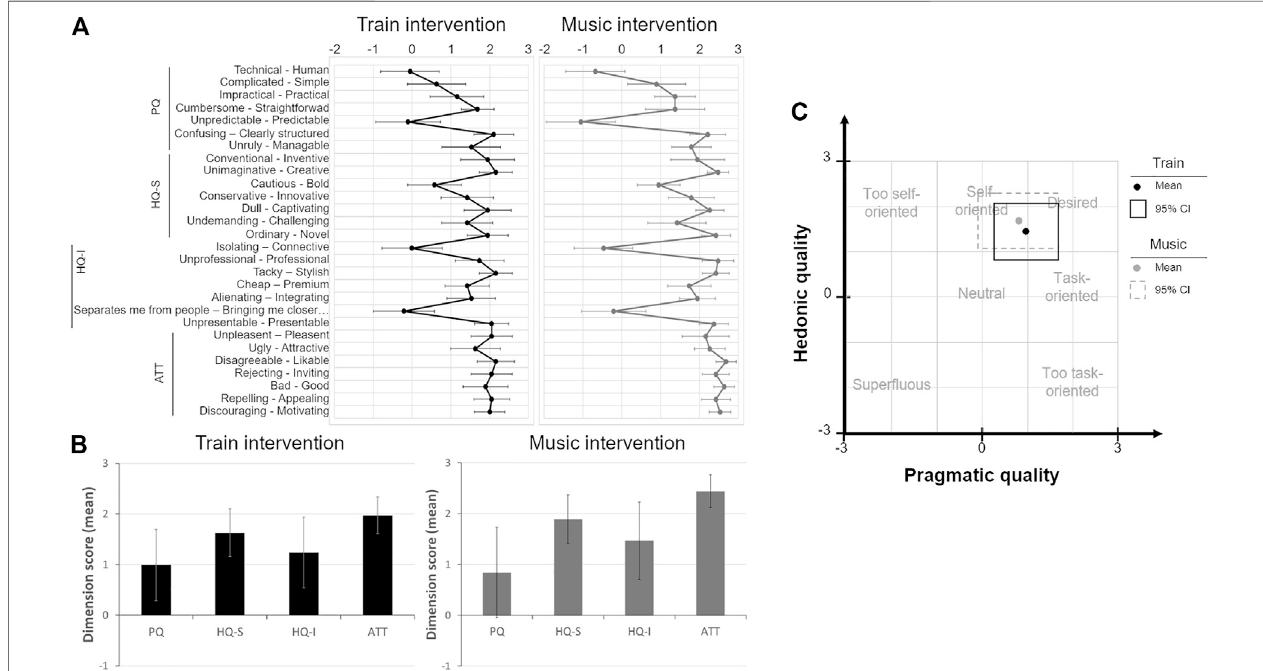
FIGURE 2 | User experience for the train and music intervention Mean scores ( ± 95% CI) for the AttrakDiff two word-pairs (A) and dimensions (B) for the train (dark black symbols and lines) and music intervention (grey symbols and lines). In (C) , PQ and HQ are plotted on the x and y axes, respectively. Black and dashed grey boxes represent the 95% CI for the train and music interventions, respectively. Framed zones represent different characteristics based on the relationship between PQ and HQ (e.g., the virtual environment is considered as “ desired ” when a score is located within the box with scores ranging from two to three in both PQ and HQ). ATT, Attractivity; CI, Con fi dence Interval; HQ-I, Hedonic Quality-Identity; HQ-S, Hedonic Quality-Stimulation.